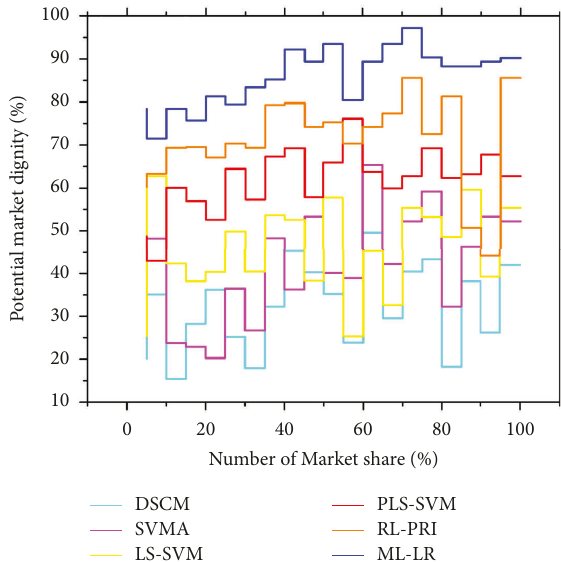
Figure 5: Analyzing credit risk with supply chain financial market